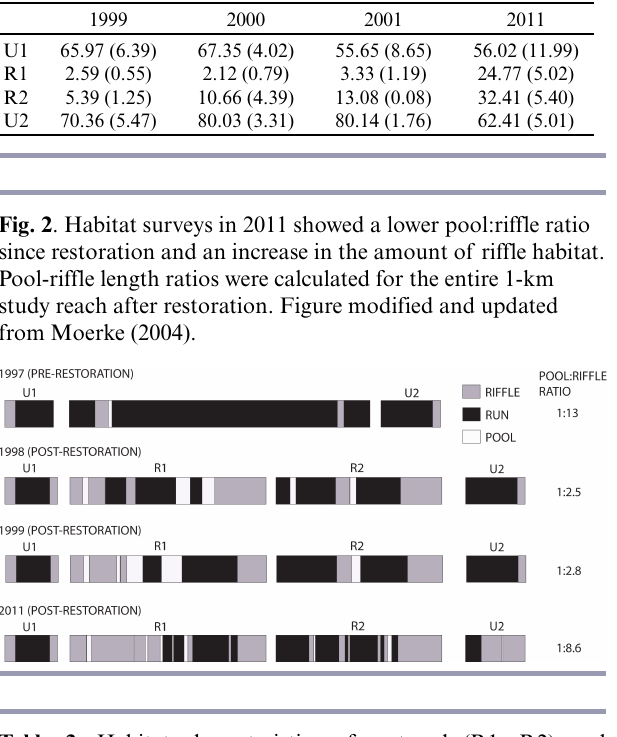
Table 3 . Habitat characteristics of restored (R1, R2) and unrestored (U1, U2) reaches of Juday Creek (updated from Moerke et al.